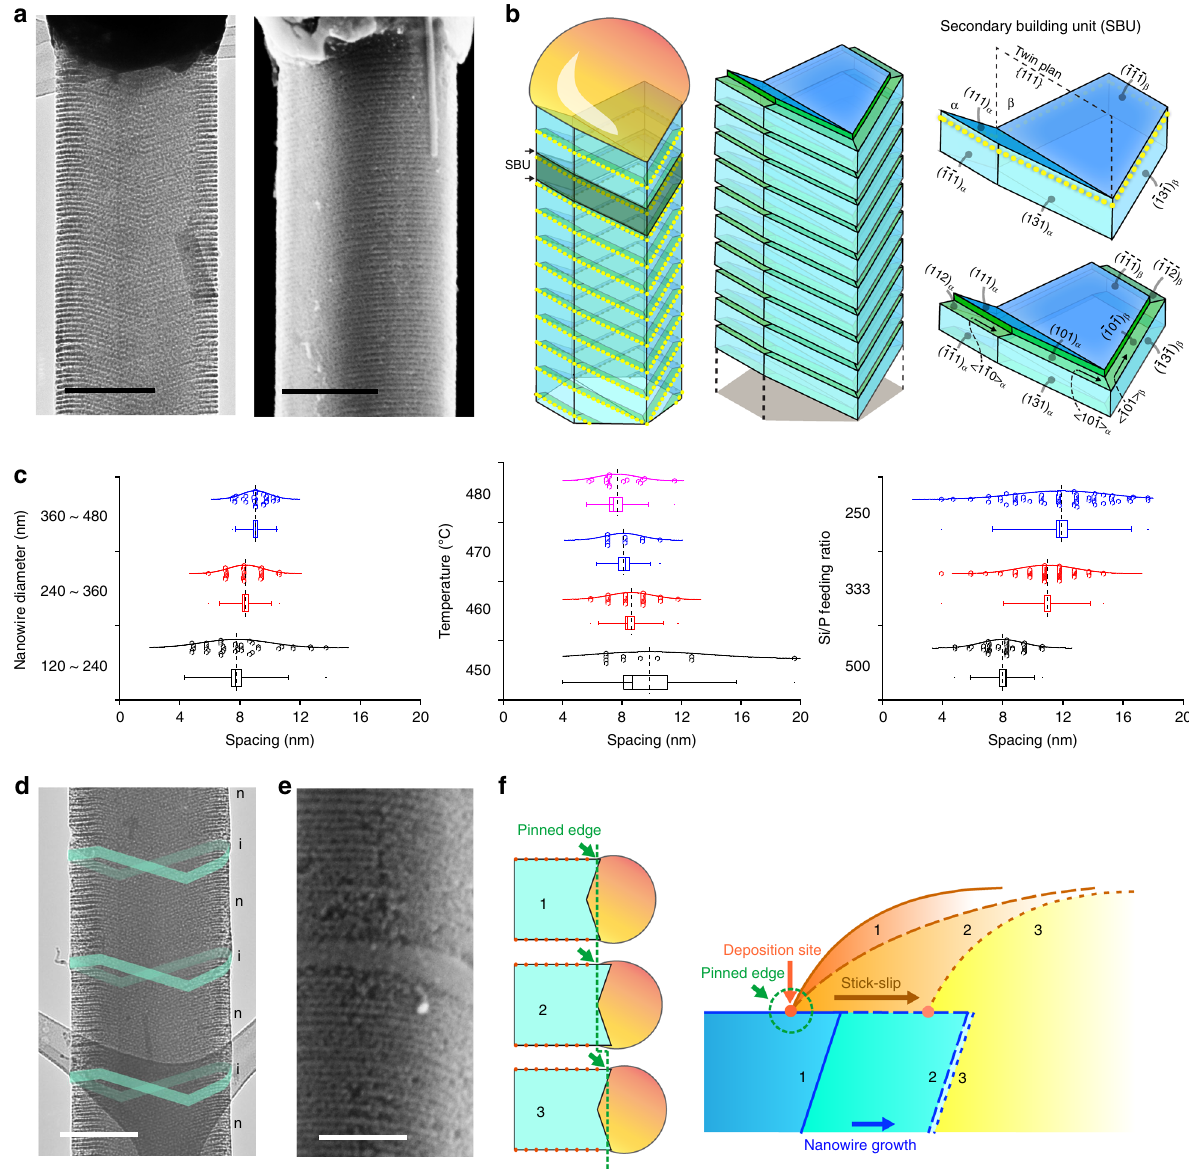
Fig. 4 Atomic Au-catalyzed etching on Si nanowires. a TEM and SEM images showing ordered and 3D grooves over the entire n -type nanowire surfaces. Scale bars, 200 nm. b Schematics of the structure model of gold line patterns and the corresponding etched grooves on Si nanowire sidewall facets. Secondary building units before and after etching are highlighted. A twin plane is usually observed for < 112 > grown Si nanowires. c Statistical analyses of the groove spacing indicate the effects of the nanowire diameter ( n = 36 (blue), 41 (red), and 43 (black)), growth temperature ( n = 21 (magenta), 11 (blue), 32 (red), and 11(black)), and Si/P feeding ratio ( n = 75 (blue), 92 (red), and 57 (black)) on the groove formation. Boxes, error bars, and dots represent standard errors, standard deviations, and maximum and minimal values, respectively. Dashed and solid lines represent mean and median values, respectively. d , e TEM and SEM images of etched dopant-modulated nanowires. Only the n -type segments yielded the grooves upon etching while the intrinsic segments (cyan ribbons in d , and the middle segment in e ) remained smooth. Scale bars, 200 nm ( d ), 100 nm ( e ). f Schematic diagrams illustrating the mechanism for atomic Au line pattern formation. A model is proposed, combining a stick-slip motion and a Au deposition process.